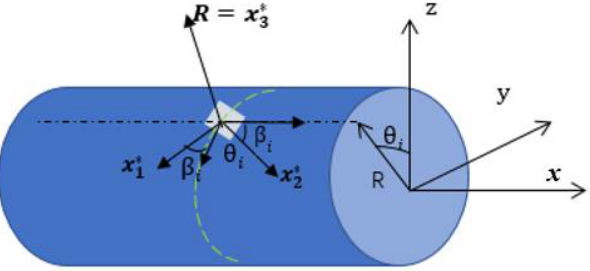
Figure 4. Location and coordinates of a strain sensor placed on an external beam surface [18].